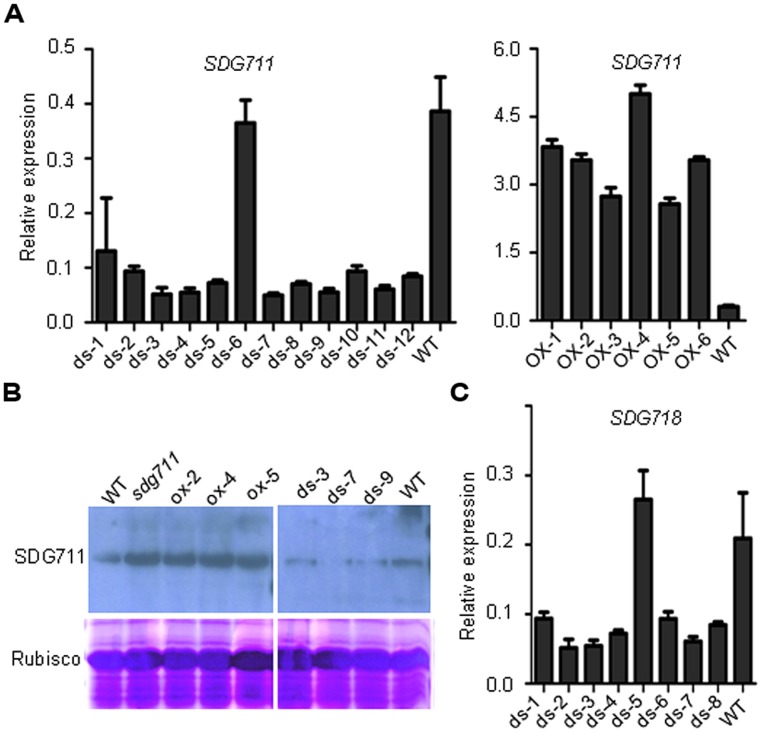
Characterization of SDG711 and SDG718 transgenic plants. (A) Detection of SDG711 mRNA levels in wild type (WT) and 12 independent RNAi (ds; left), and six over-expression (OX) lines (right).(B) Detection of SDG711 protein levels in WT, three OX and three RNAi lines, and the gain-of-function mutant (sdg711). (C) Detection of SDG718 mRNA levels in WT and eight independent RNAi lines. Y-axis: relative expression levels to ACTIN transcripts. Bars = means ± SD from three technical repeats.